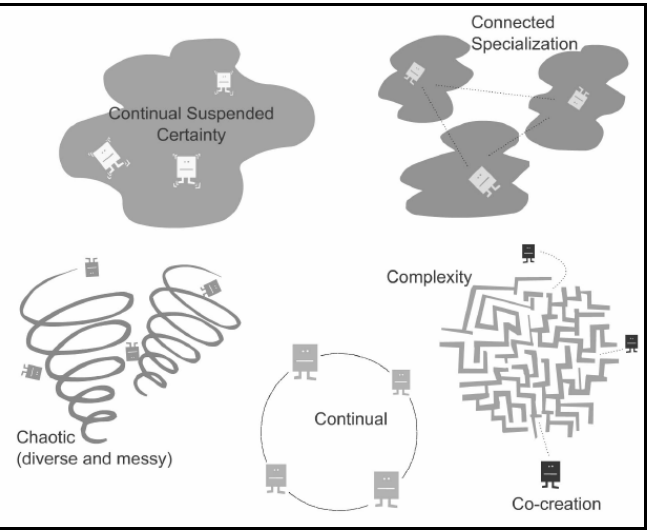
Figure 1 . Traits of Learning Today (Siemens,